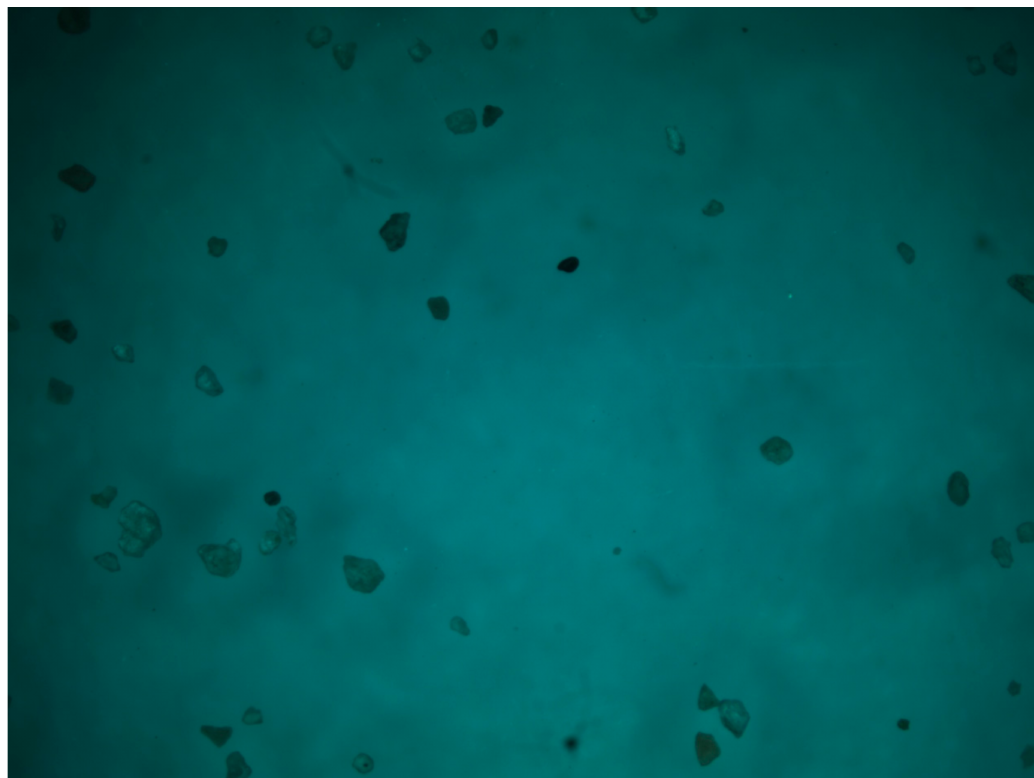
Figure 14. Particles in a non-Newtonian fluid with bubble